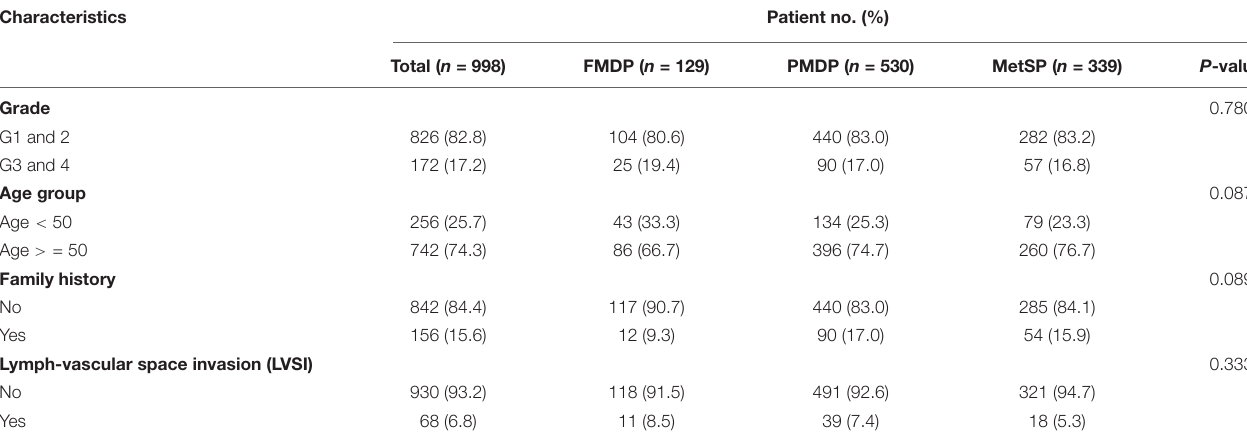
TABLE 1 | Characteristics of free metabolic disorder in patients (FMDP), partial metabolic disorder in patients (PMDP), metabolic syndrome in patients (MetSP) patients in the training set ( n = 998).